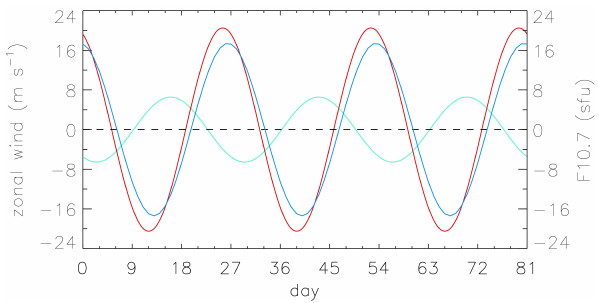
Figure 8. Fitted oscillations of zonal winds at (red) 90km and (green) 32km, and (blue) F10.7.